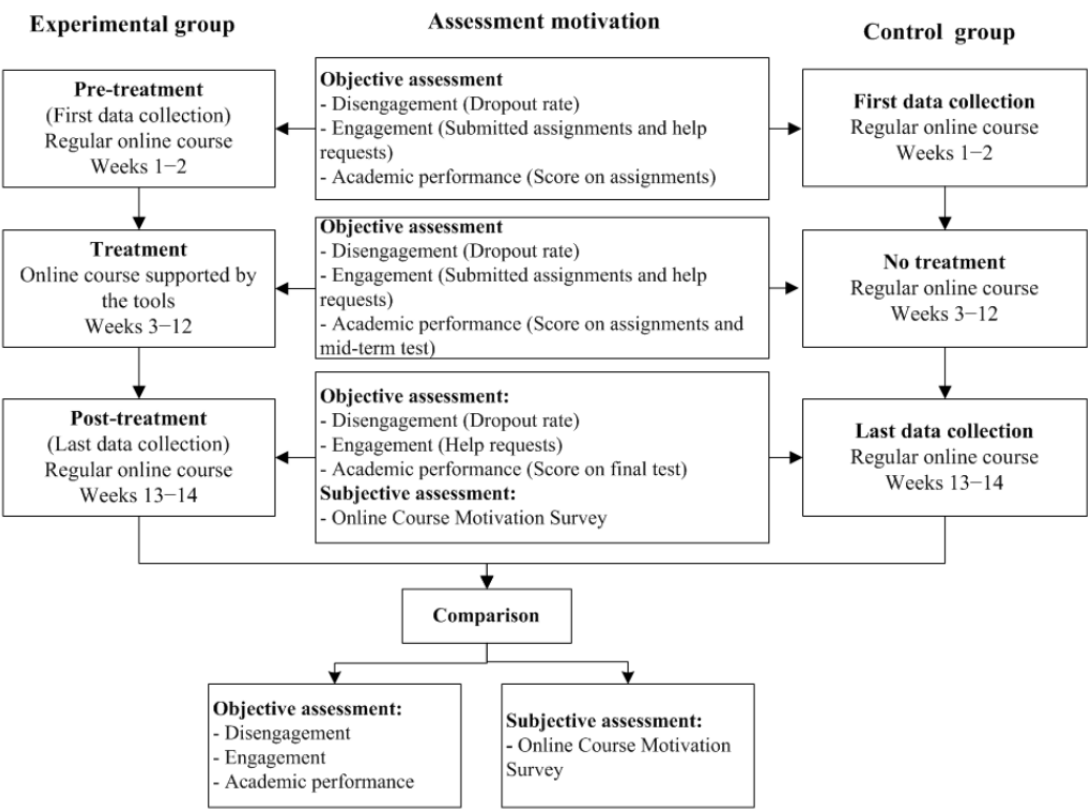
Figure 1. Experimental